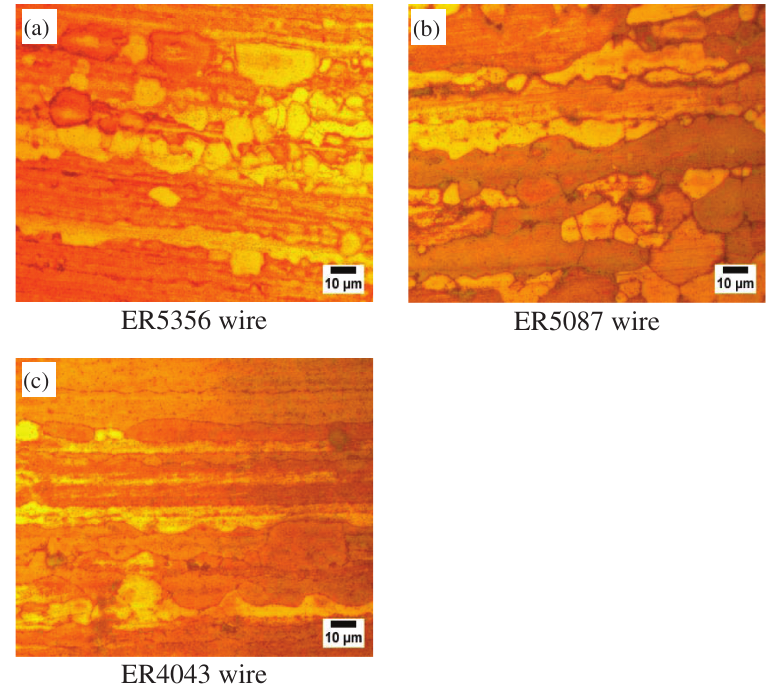
Figure 6: Microstructure of the heat affected zone.